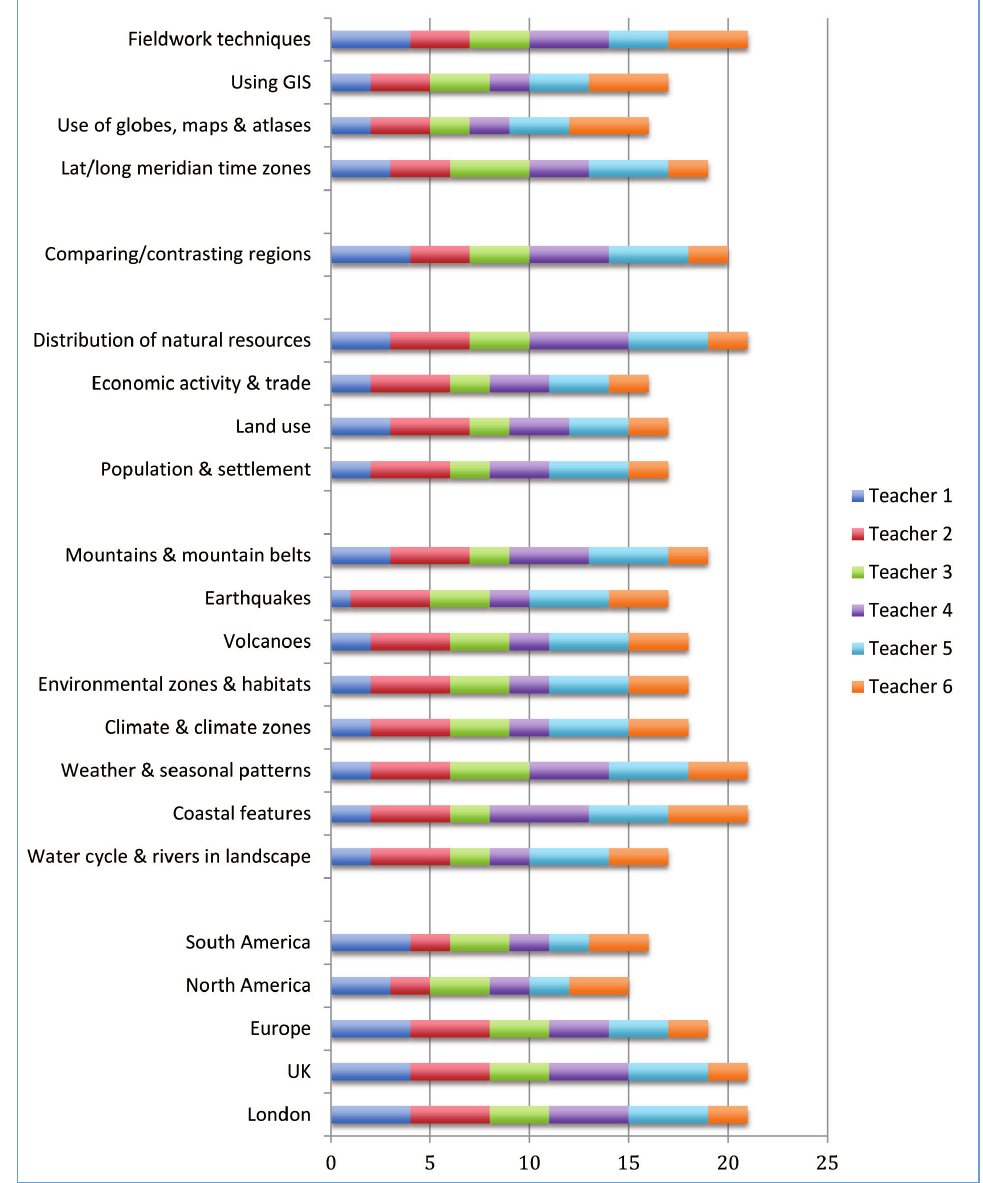
Figure 3:  Primary teachers’ subject knowledge confidence by national curriculum topic (baseline). Cumulativeforeachtopic:teachers’self-scoreoflevelofsubjectknowledgeandunderstanding.